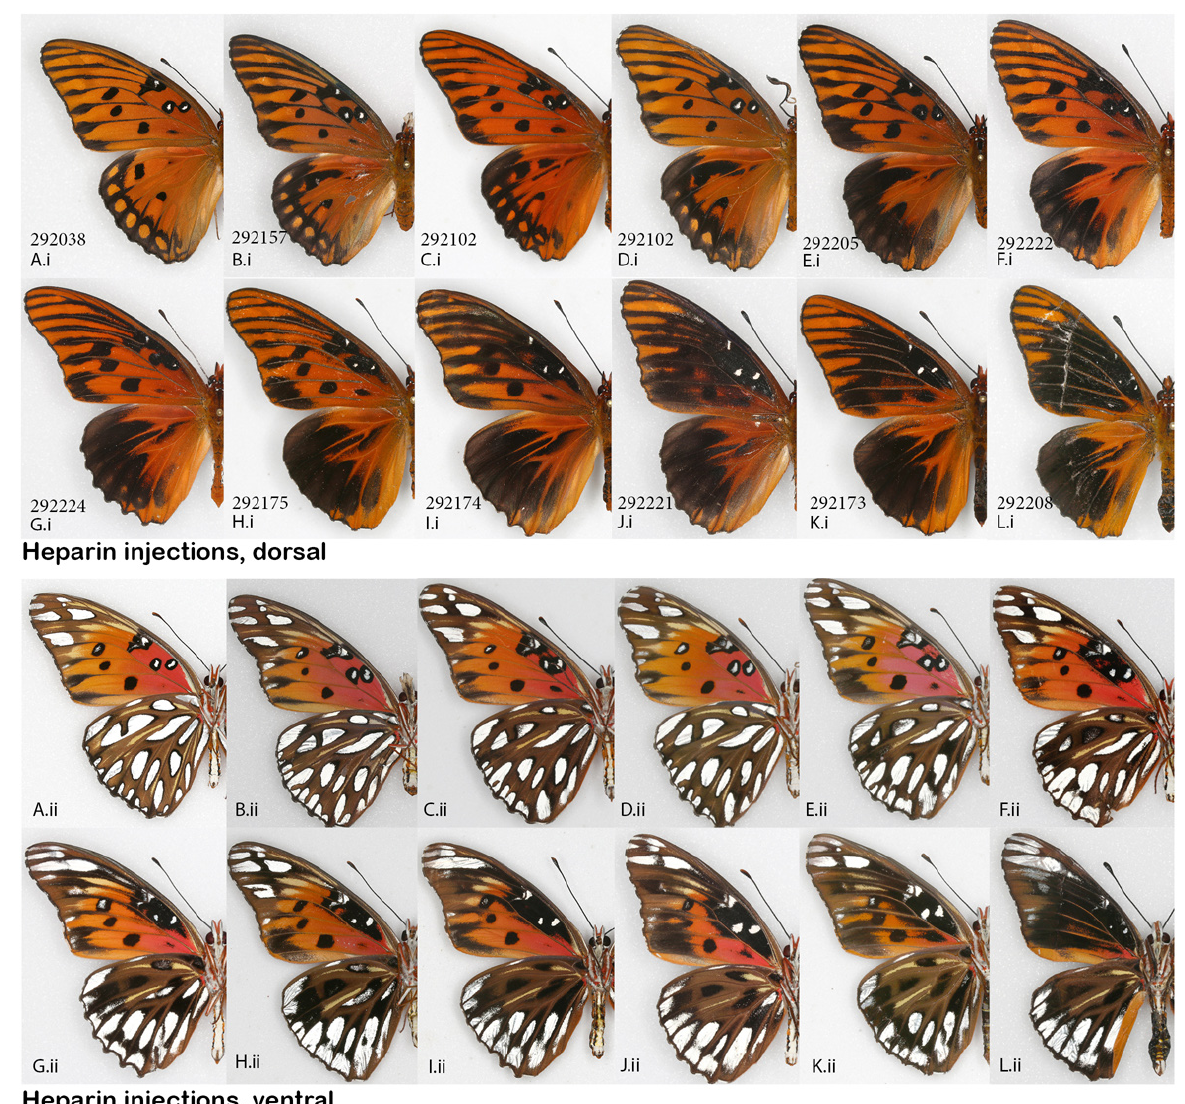
Figure 6. Heparin-induced wing pattern changes in the gulf fritillary, Agraulis vanillae when injected as prepupae ( A , B , D , E , J – L ) or pupae ( C , F – I ); ( i ) dorsal, ( ii ) ventral surfaces. See Extended Data (Sourakov, 2020) for